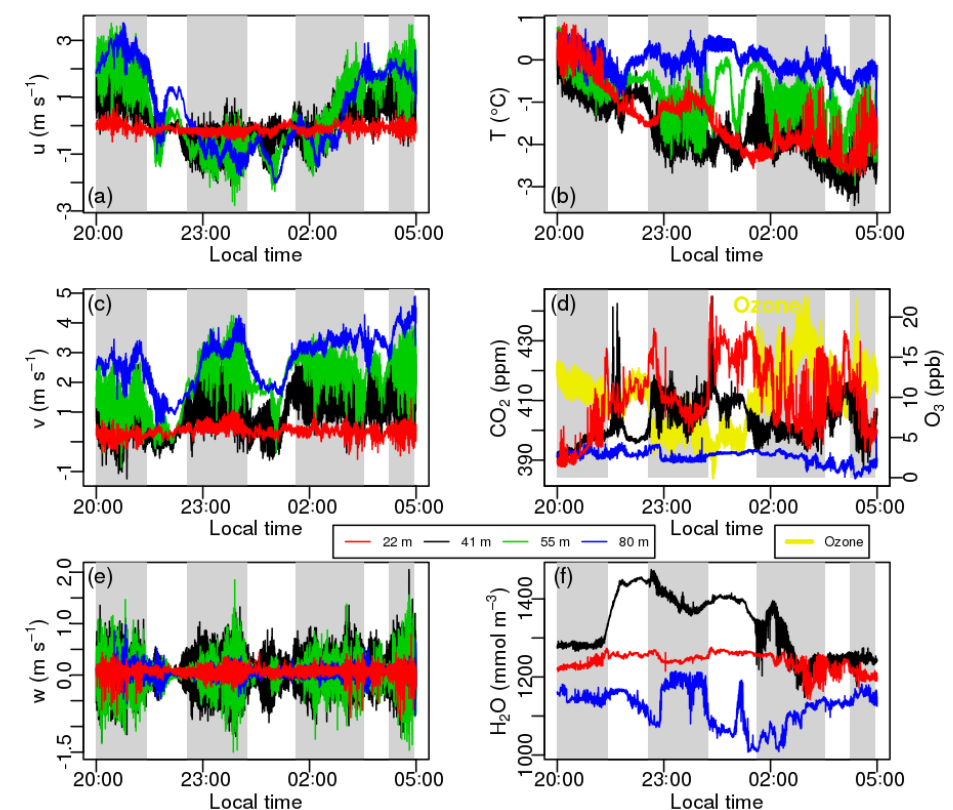
Figure 2. Same as Fig. 1 but for the intermittent night. Shaded areas indicate intermittent turbulence bursts.